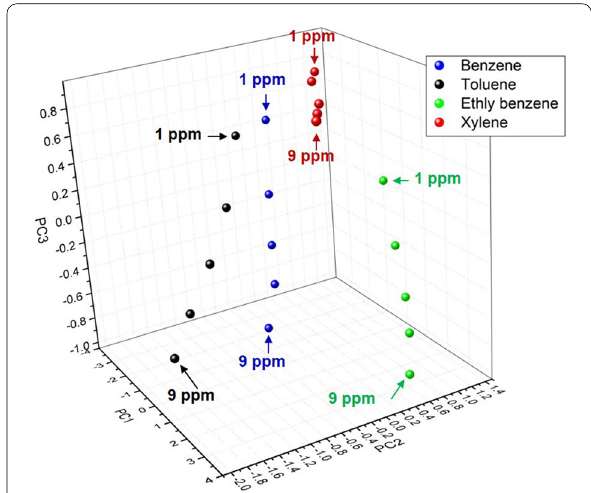
Fig. 6 PCA result with experimental sensing data measured using a sensor array composed of four kinds of sensors